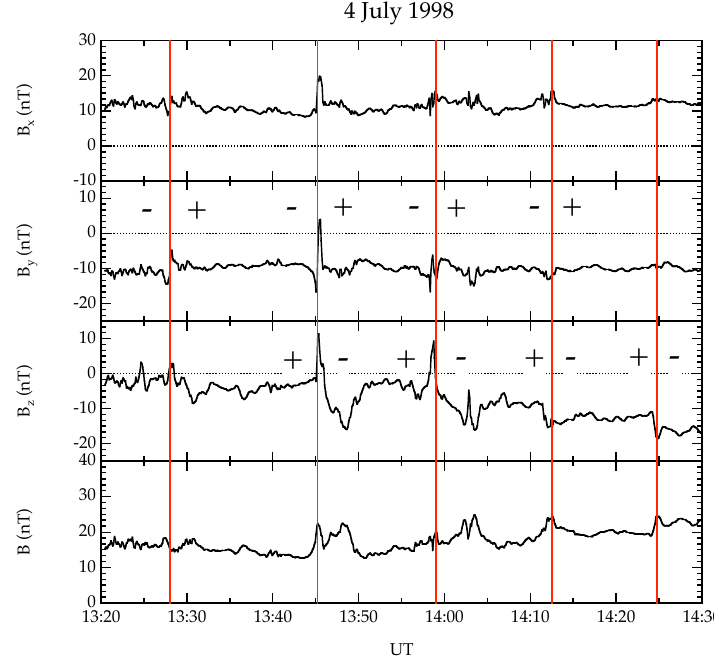
Fig. 6. Interball-1 magnetometer observations from 13:20 to 14:30 UT on 4 July 1998 in GSM coordinates. Interball-1 remained within the magnetosphere throughout the interval, where it observed the sequence of FTEs marked by vertical lines. The bipolar signatures were initially more pronounced in the y-component, but later became more readily visible in the z-component.